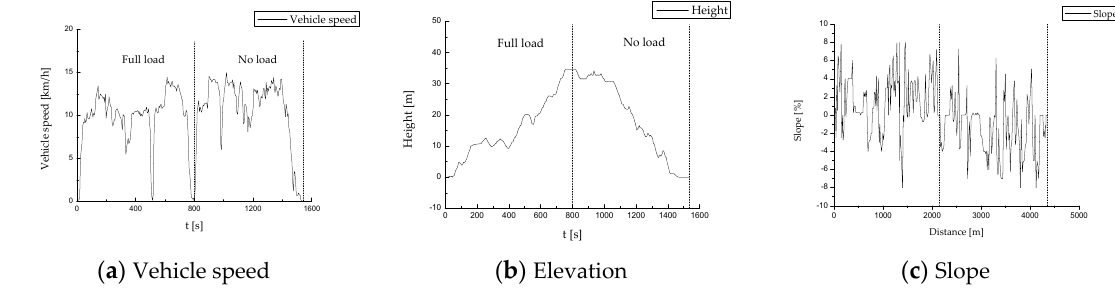
Figure 8. Road drive cycle. ( a ) Vehicle speed; ( b ) elevation; ( c ) slope.